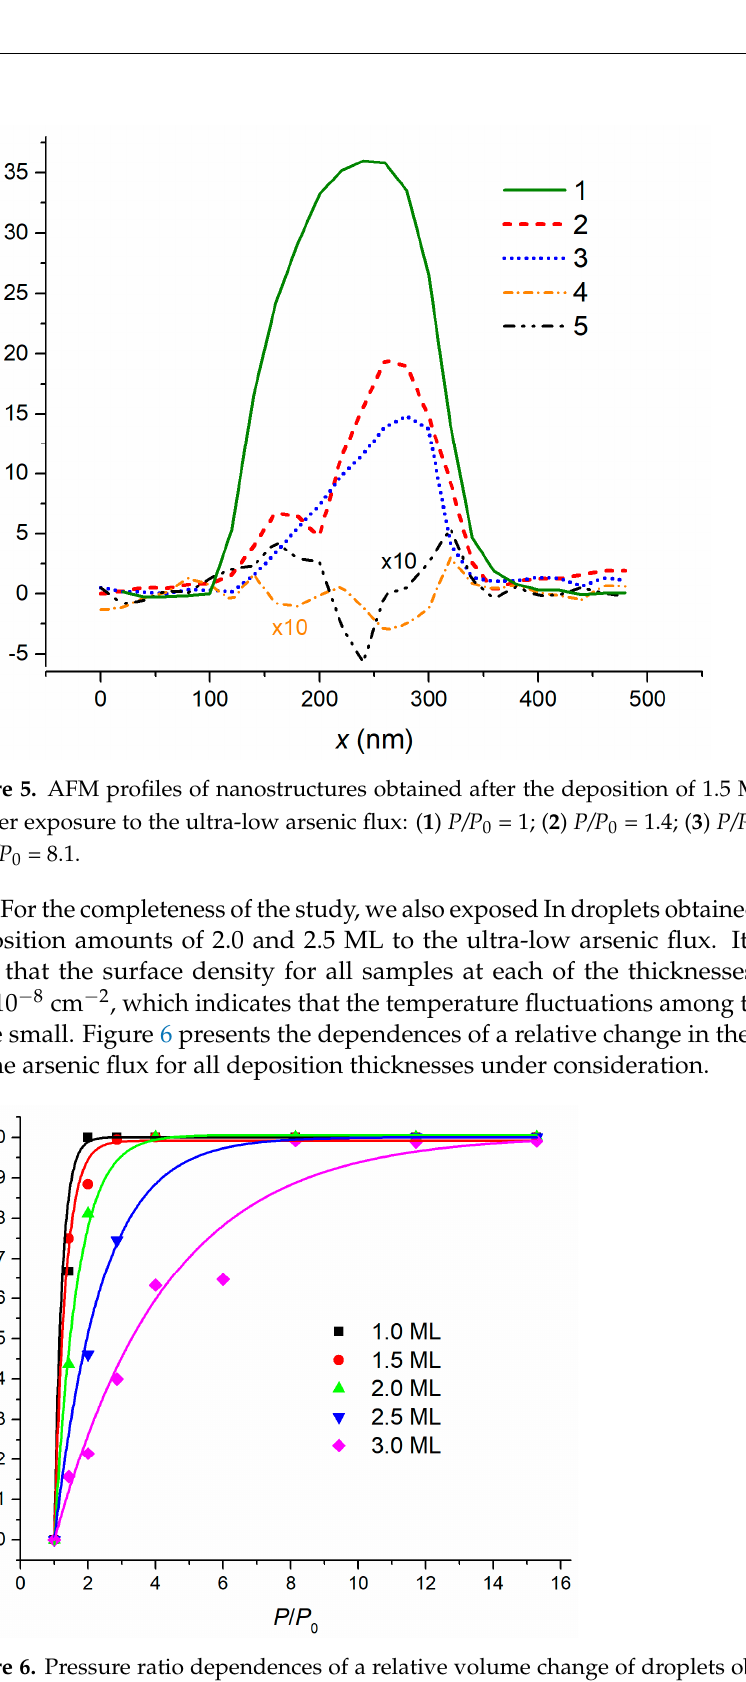
Figure 6. Pressure ratio dependences of a relative volume change of droplets obtained at various deposition amounts.